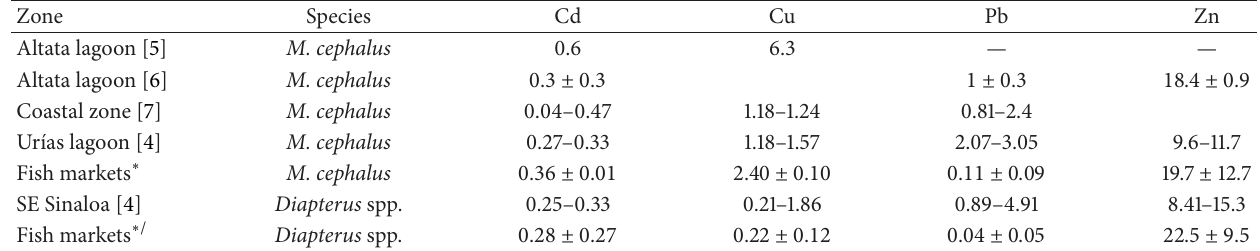
Table 3: Comparison of the metal contents ( 𝜇 gg − 1 , dry weight) of the muscle of Mugil cephalus and Diapterus spp. determined in samples collected in Sinaloa state, NW